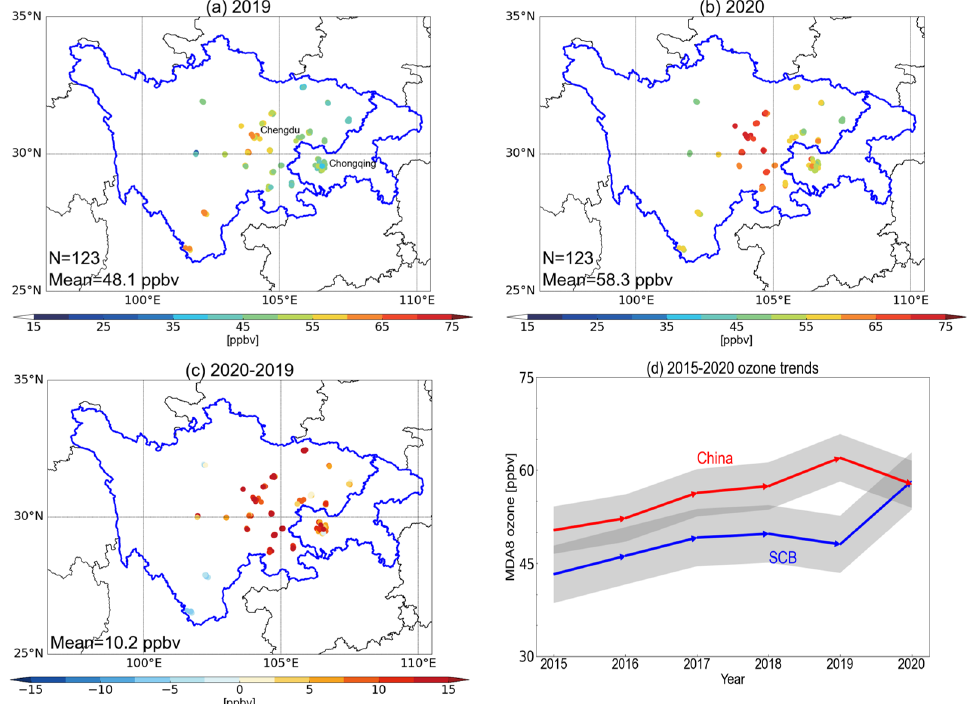
Figure 1. Surface O 3 enhancements over the SCB region in May–June 2020 relative to 2019. (a) Spatial distributions of May–June mean O 3 concentrations over the SCB region in 2019. Number (N) denotes the available measurement sites for this year. We average the O 3 concentrations at all measurement sites in each city to form an O 3 dataset representative of the respective city. Panel (b) is the same as panel (a) but for 2020. Panel (c) shows the differences between 2020 and 2019. (d) Trends in May–June mean ozone concentrations from 2015 to 2020 averaged for all Chinese cities (red) and for the SCB city cluster (blue). Grey shading represents the mean ± 1 σ SD across all cities. The base map of the figure was created using the Basemap package in